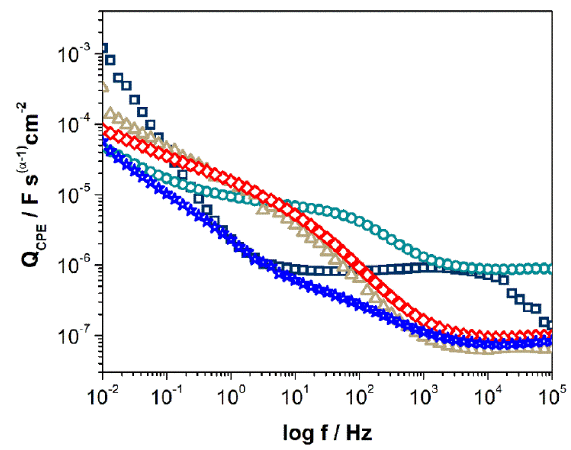
Figure 14. Impedance matching parameters using copper CPE parameters. Exposure at 0 months (□), 3 months ( ○ ), 12 months ( △ ), 24 months ( ◇ ), and 36 months ( ☆ ). The infinite capacitances (C ∞ ) were estimated from the Cole–Cole diagram [52,53] for copper samples exposed to the environment for up to 36 months, as shown in Figure 15. The segmented lines represent the criteria used in the determination of C ∞ , giving by ex‑ trapolation the real capacitance (C real ) using the slope of the complex capacitance at HF. In addition, Figure 15 shows the variation of C ∞ obtained from the extrapolation line with a positive slope for all the evaluated systems, revealing that the highest value of C ∞ was